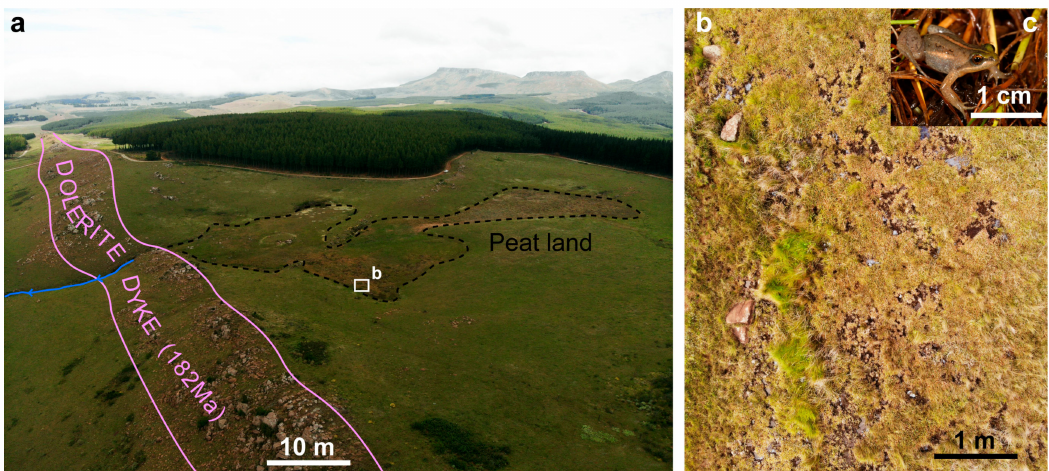
Figure 7. Biological survey by drone at Tor Doone, near Hogsback (Figure 1 for location): ( a ) Aerial photo of the peatland habitat upstream a dolerite dyke intruded at 182 Ma; ( b ) water pools decimeters in size and depth; and ( c ) Cacosternum thorini , one of the rarest frogs in South Africa (photo by Werner